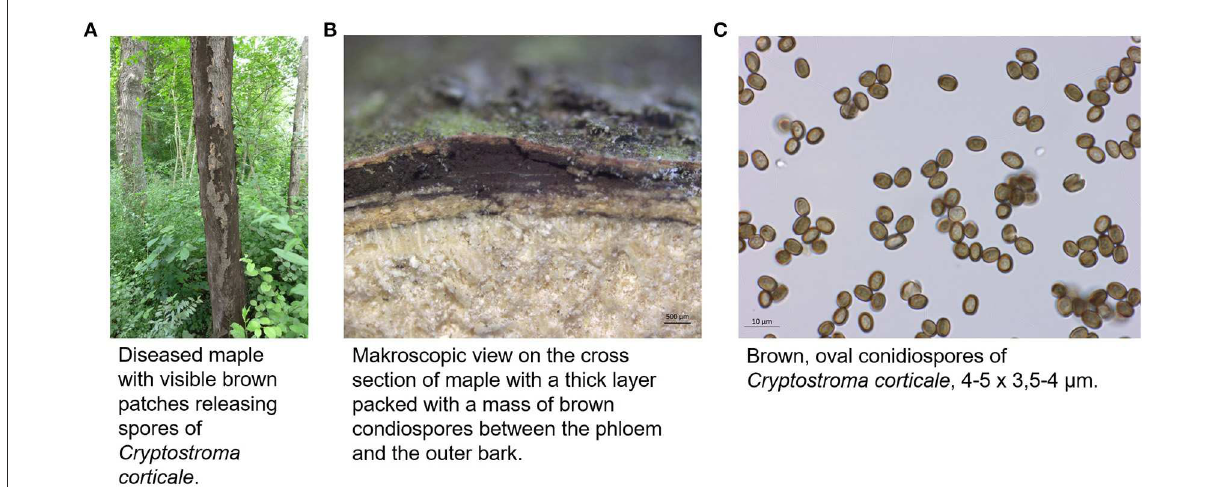
FIGURE1 Appearance of C. corticale (A) on maple tree, (B) under the bark of maple trunk, (C) light microscopy of conidiospores (JKI-GFF-2019-006).